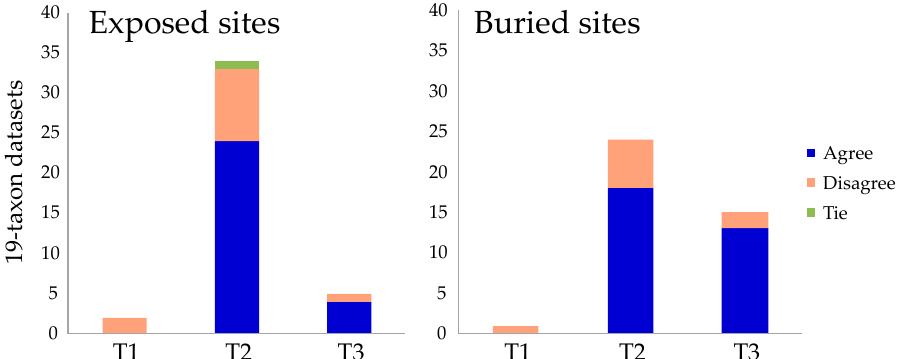
Figure 2. The position of the metazoan root based on tree searches and the strongly decisive sites criterion. These histograms show the number of times each topology was recovered in tree searches using 19-taxon datasets. Each histogram column is subdivided into cases where the decisive sites criterion agrees (blue) or disagrees (salmon) with the result of the tree search. There was one exact tie in the number of strongly decisive sites supporting T2 and T3, and this case is indicated in green. Most cases where the tree search and decisive sites differed reflect a shift from T2 to T3.